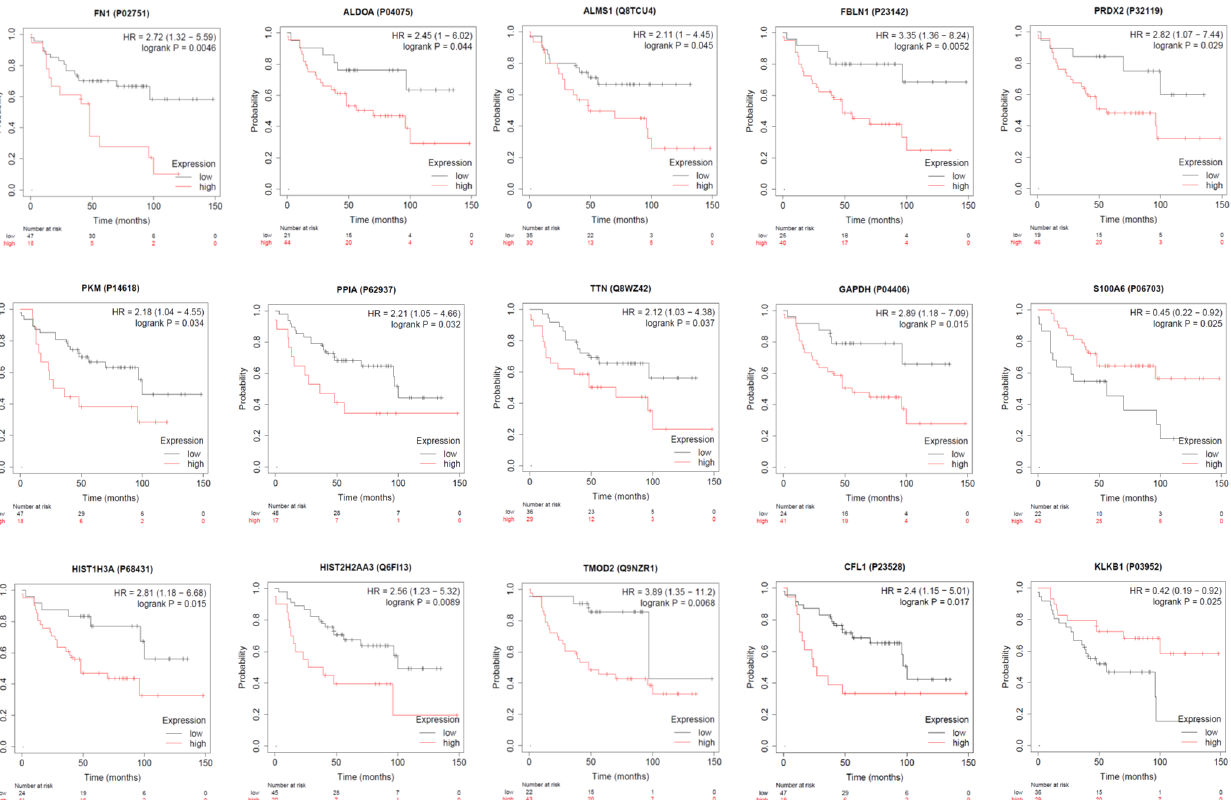
Figure 5. Candidate extracellular vesical associated proteins were able to discriminate the responder from the non-responder regardless of time assayed. ( A ) Unit variance scaling and SVD with imputation was used to calculate principal components. X and Y axis show principal component 1 and principal component 2 that explain 60.6% and 15.9% of the total variance, respectively. ( B ) Euclidean clustering distance and Ward clustering method were used to generate the heatmap. Temporal samples from the responder (green) or the non-responder (red) grouped closely with each other. NR, non-responder; MR, mixed-responder; R, responder.